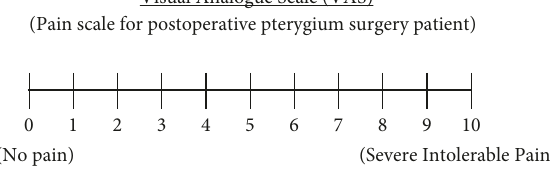
Figure 1: VAS (visual analogue scale) for pain assessment after pterygium